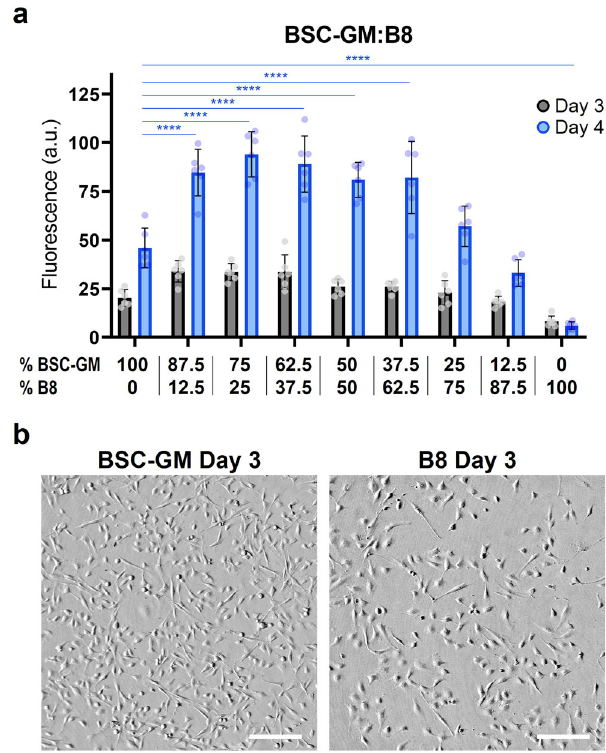
Fig. 1 Short-term growth in BSC-GM mixed with B8. a BSC proliferation over 3 & 4 days in mixtures of BSC-GM (20% FBS) and B8 media. At the four-day timepoint, mixtures of up to 62.5% B8 signi fi cantly improved growth compared to BSC-GM alone, and mixtures of up to 87.5% B8 did not signi fi cantly reduce growth ( p = 0.27). B8 alone showed a signi fi cant reduction in growth over four days compared with BSC-GM alone, and showed stagnating growth after three days. n = 6 distinct samples; statistical signi fi cance was calculated by one-way ANOVA on day 4 data comparing all samples with BSC-GM controls, and is indicated by asterisks, in which p < 0.05 (*), p < 0.01 (**), p < 0.001 (***), and p < 0.0001 (****). b Bright fi eld images of BSCs grown for three days in BSC-GM or B8 media. Images show that cell morphology was consistent in serum-containing or serum-free conditions. Cell con fl uency in the images is qualitatively consistent with growth analysis in part ( a ). Scale bars are 200 μ